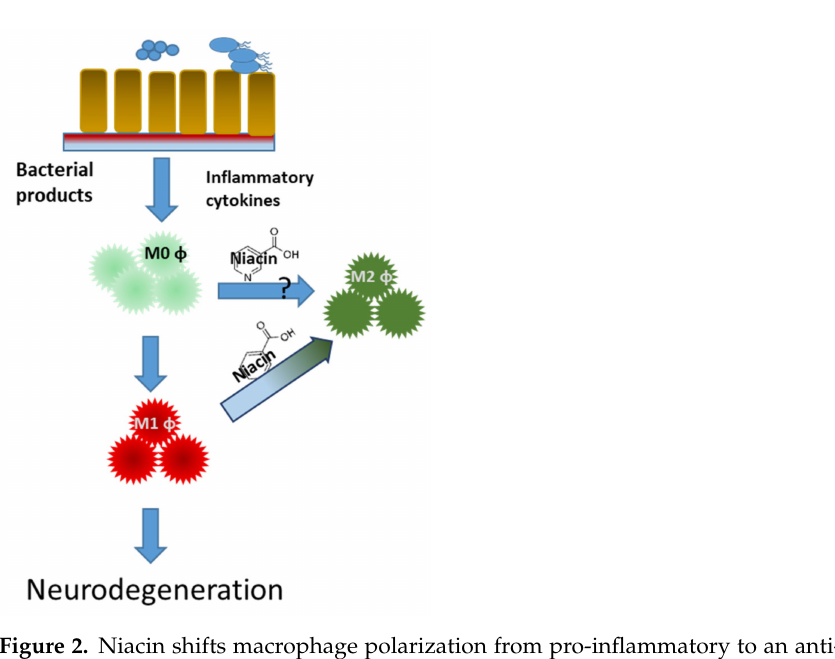
Figure 2. Niacin shifts macrophage polarization from pro-inflammatory to an anti-inflammatory profile in Parkinson’s disease patients. Naïve (M0 ϕ ) pro-inflammatory (M1 ϕ ) and anti-inflammatory (M2 ϕ )